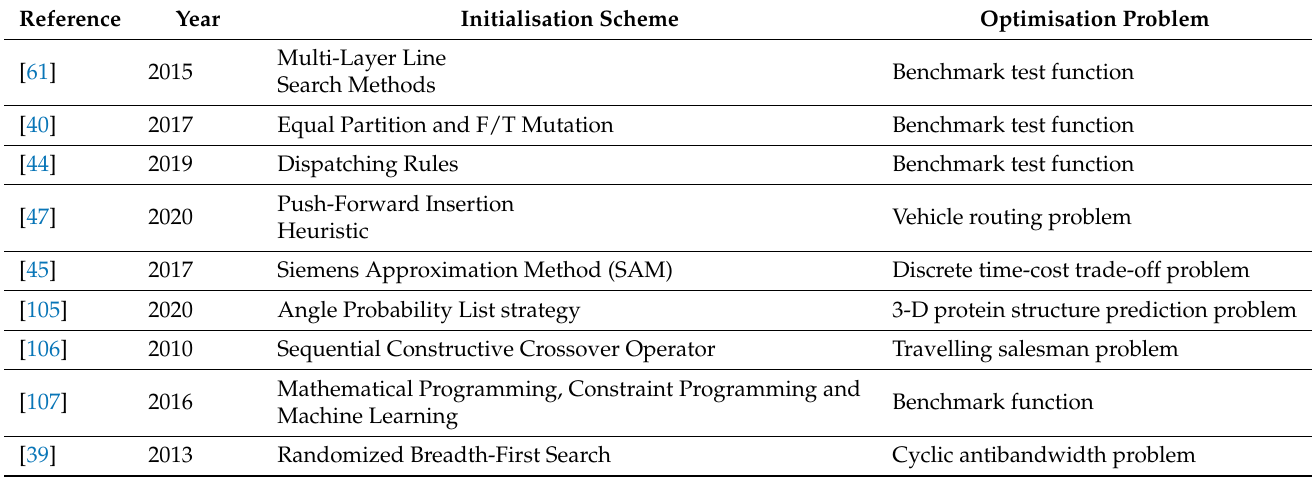
Table 8. Other approaches to improving initialising